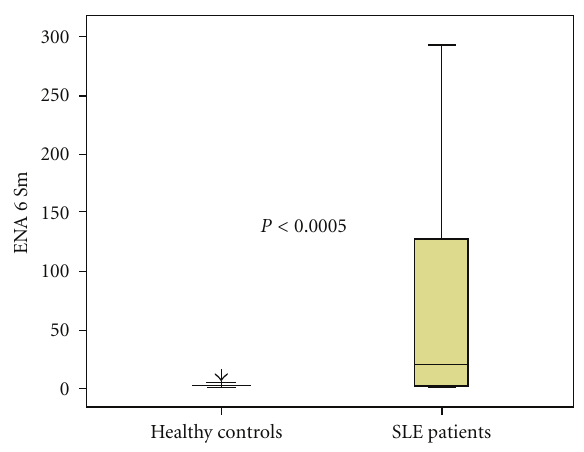
Figure 2: Serum CIC concentration in healthy controls and SLE patients. Each bar shows upper and lower quartile, while the square and its central bar indicate interquartile range and median.